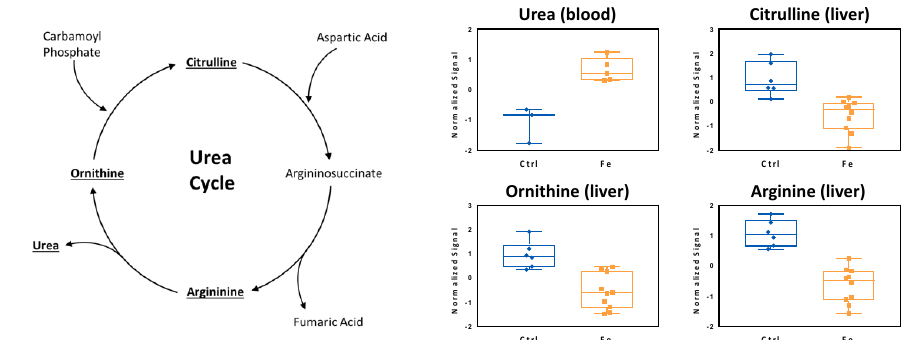
Figure 2. High iron diet induces the urea cycle in the liver, thereby enhancing the levels of urea in blood. Higher levels of the metabolite urea were detected in the blood and this was concomitant with an enhanced urea cycle, driving to lower levels of ornithine, citrulline, and arginine in the liver. Controls (Ctrl, blue, n = 3), high-iron diet (Fe, orange, n = 5). In the liver, each sample was run in duplicates. Statistics: Student t -test was performed, a p -value < 0.05 was considered to be significant.